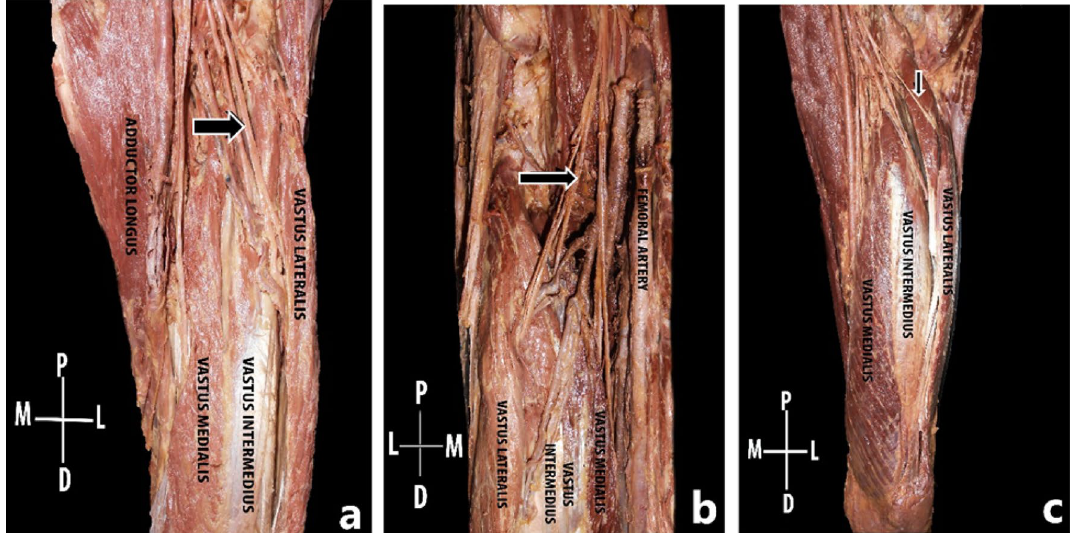
Figure 7. Anterior aspect of the thigh; The arrows indicating the nerve supply of the additional muscle head; by the direct branch of femoral nerve ( a ), by the nerve to vastus lateralis ( b ) and by the nerve to vastus intermedius ( c ).